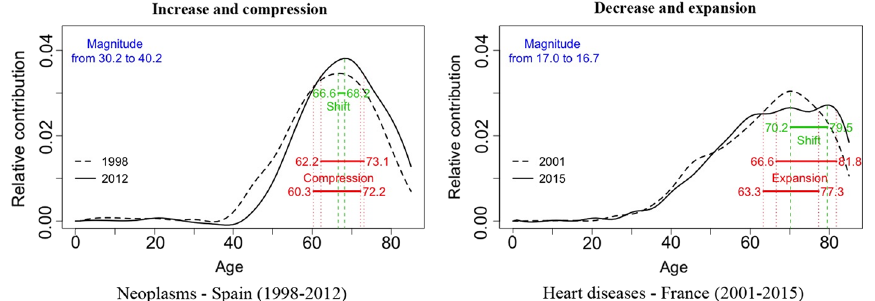
Fig. 4 Trends in the mode, measure of variation and magnitude of distributions of relative age-specific contributions to the sex gap in life expectancy at the beginning (dashed line) and at the end of the observation period (solid line), for neoplasms in Spain 1998–2012 and for heart diseases in France 2001–2015. Increase/decrease denotes increasing/decreasing relative cause-specific contributions (i.e., magnitude) to